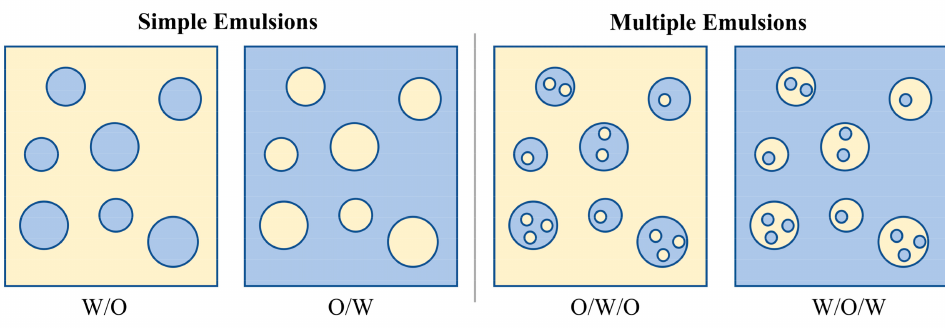
Figure 2. The four basic forms of simple and multiple emulsions.